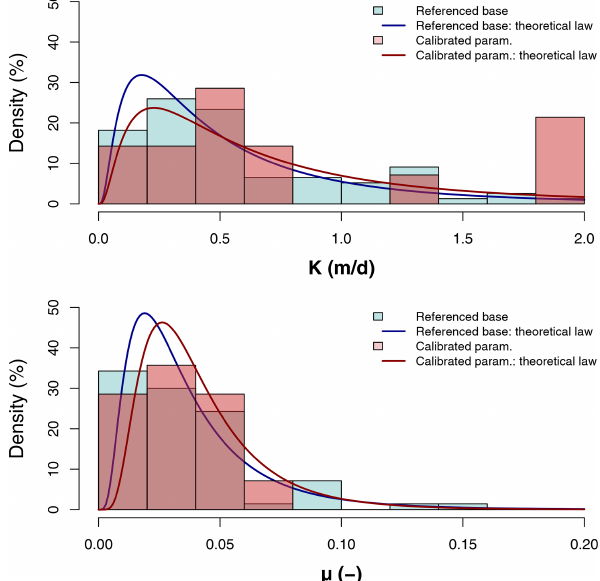
Figure 11. Distribution of K and µ from calibrated values on silty soils vs. values extracted from reference drainage sites placed on silty